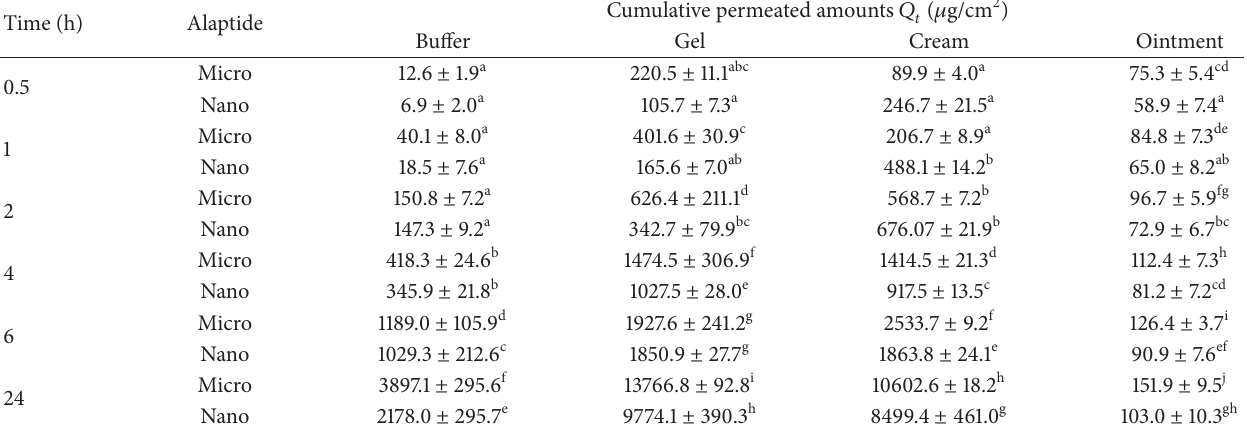
Table 1: Cumulative permeated amounts 𝑄 𝑡 per unit area ( 𝜇 g/cm 2 ) of micronized/nanonized alaptide from buffer and from various semisolid formulations achieved in in vitro transdermal permeation experiments performed using Franz diffusion cell. Cumulative permeations are expressed as mean ± SD ( 𝑛 = 5